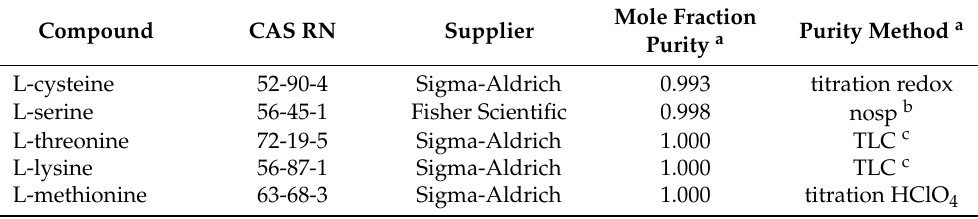
Table 7. Sample Table 7. Sample Description .